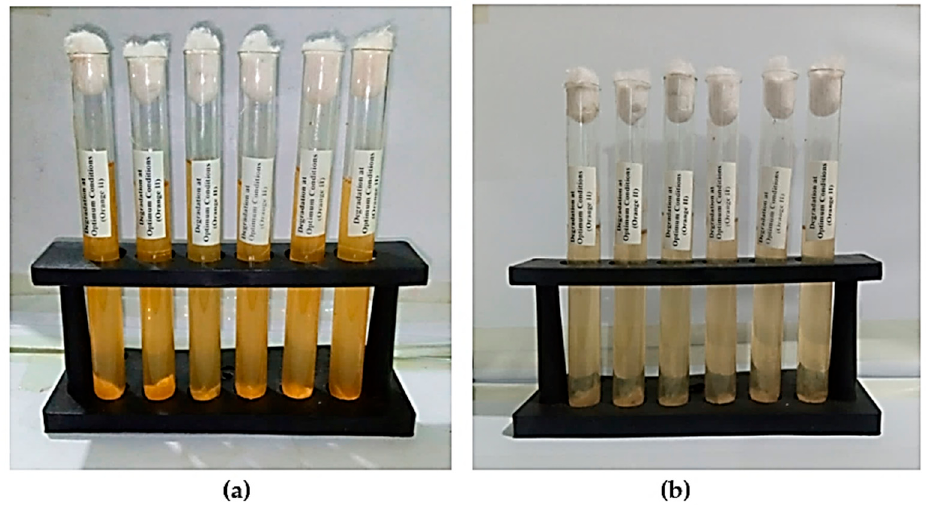
Figure 3. Orange II dye ( a ) before bacterial degradation and ( b ) after B. subtilis treatment.